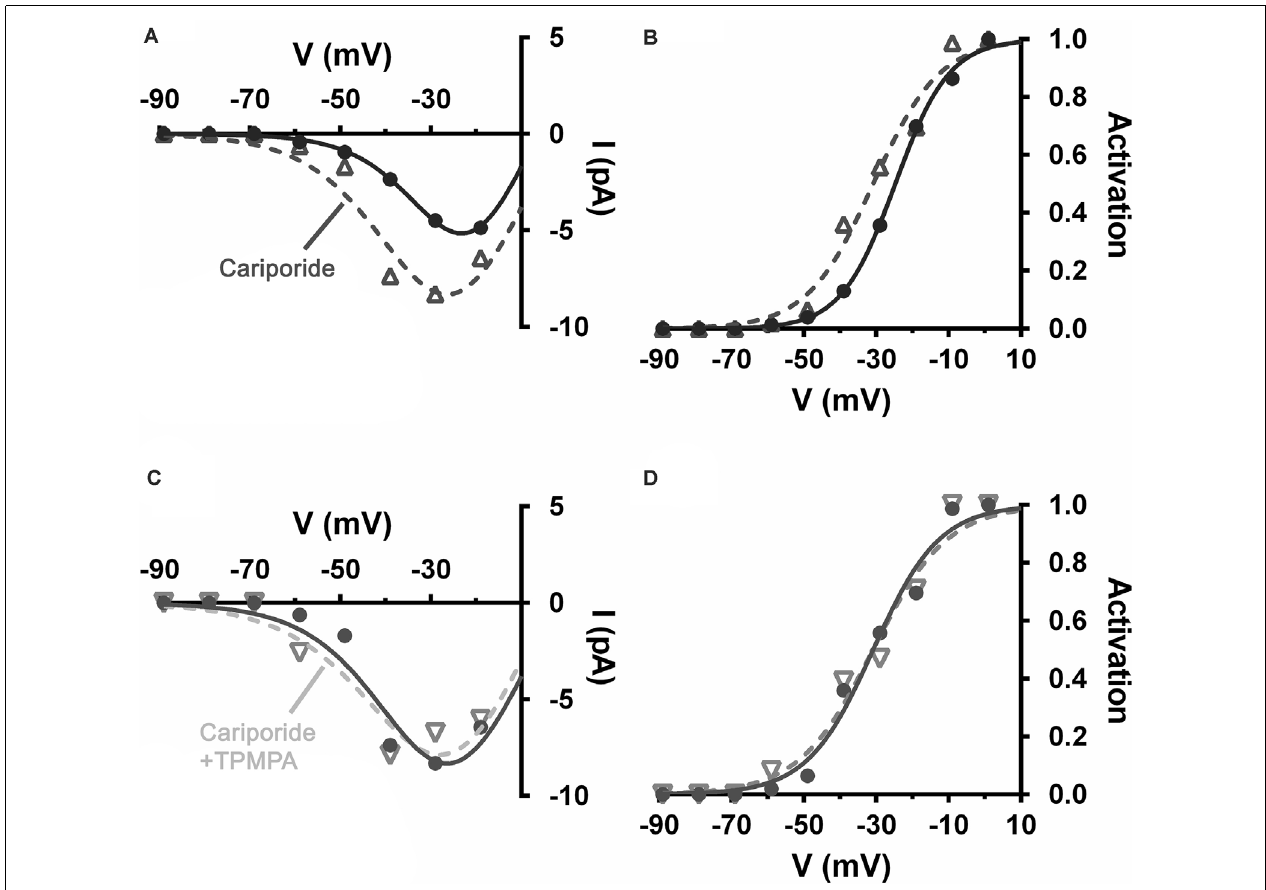
FIGURE 10 | Alkalinization of the extracellular space produced by blocking Na + /H + exchangers (NHEs), disinhibited cone Ca V and occluded disinhibition by TPMPA. Recording of Ca V currents in a mouse cone. (A) I–V relations show larger currents in the presence of cariporide (dashed line, open triangles) relative to control (solid line, filled circles). (B) The cone Ca V activation curve shifts to a more negative potential following cariporide application (dashed line, open triangles). (C) In the same mouse cone bathed continuously with cariporide, I–V relations showed no effect of TPMPA on Ca V current (dashed line, inverted triangles). (D) TPMPA failed to shift the Ca V activation curve to more negative potentials (dashed line, inverted